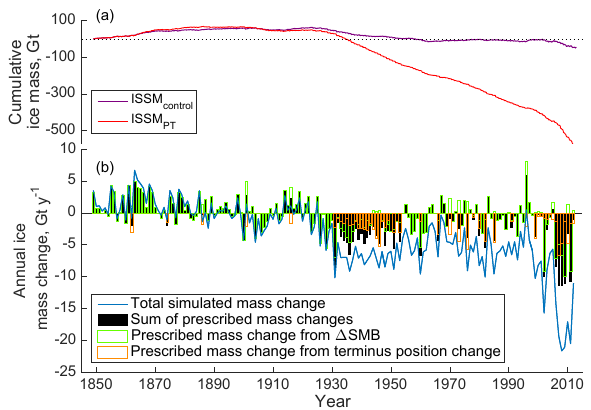
Figure 2. (a) Simulated cumulative ice mass in Gt. ISSM PT changes are shown in red; control run changes in purple. (b) The blue curve illustrates simulated annual change in ice mass for ISSM PT . The black bars indicate the ice mass that is removed due to (cid:49) SMB and prescribed changes of the terminus position. The area between the blue line and black bars corresponds to ice mass changes caused by changes in the ice dynamics that where not pre- scribed. The green outline marks the portion of mass change due to (cid:49) SMB, and the orange outline the share of prescribed terminus